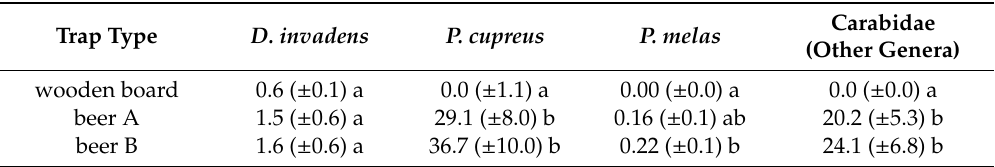
Table 3. Mean catches ( ± SE, n = 64) of D. invadens and ground beetles ( P. cupreus , P. melas and other Carabidae) in trial no. 2 according to the di ff erent type of